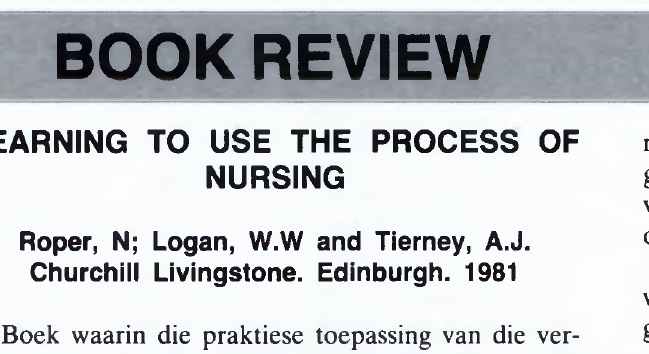
pleegproses toegelig word. Die verpleegproses self word selgs kortliks bespreek. D aarom kan hierdie boek hoofsaaklik beskou word as ’n toepassing van die ele-